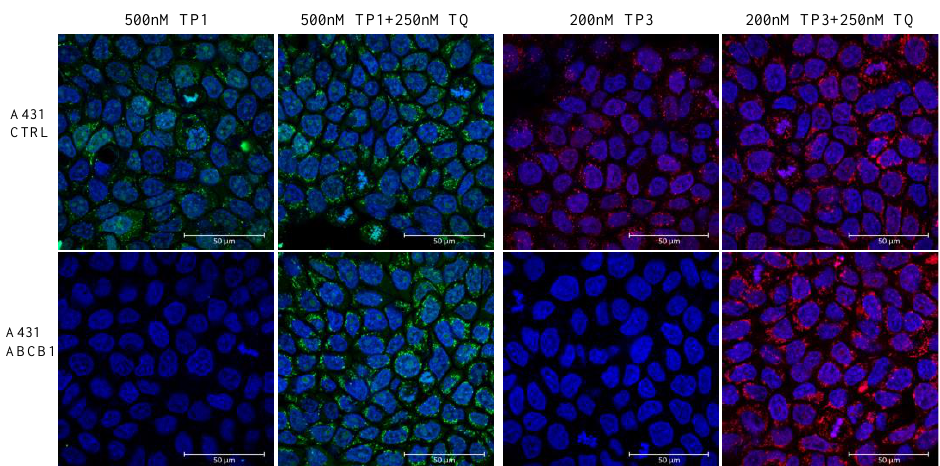
Figure 5. Fluorescent TP1 or TP3 accumulation in human A431 cells, examined by confocal micros- copy. Effects of ABCB1 protein expression and the specific inhibition of the transporter function by Tariquidar. Cellular fluorescence was followed by confocal microscopy. TP1 fluorescence (green) or TP3 fluorescence (red) was examined after 24 h of the addition of 500 nM TP1 or 200 nM TP3 to the medium, either in the absence or presence of the transporter inhibitor (250 nM Tariquidar for ABCB1). The nuclei were counterstained with DAPI.